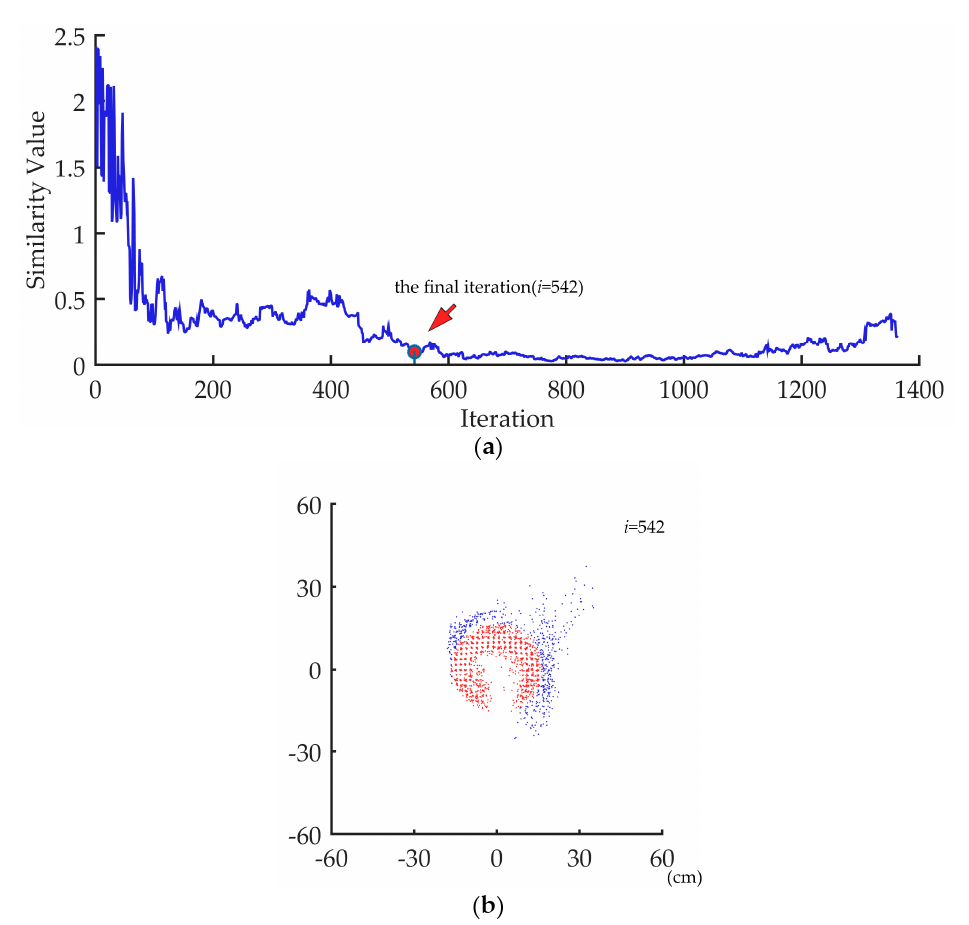
Figure 9. ( a ) The final iteration for outermost points removal. ( b ) The remaining point cloud when the termination criterion has been reached. Red points are the remaining points, while blue points are the removed points.